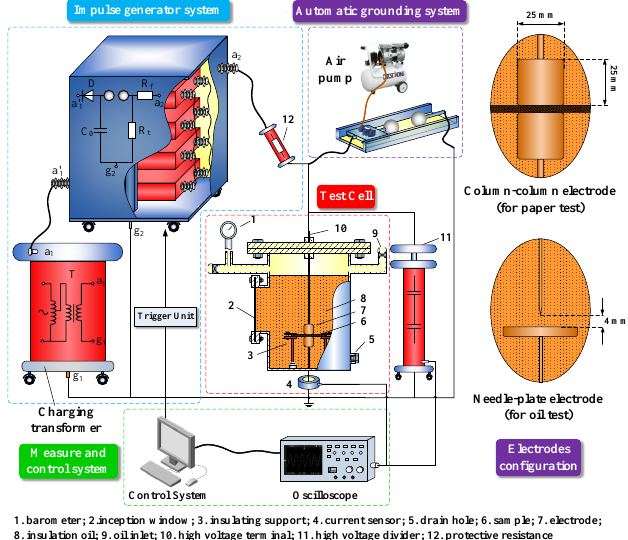
Figure 2. Sketch of impulse voltage test setup.